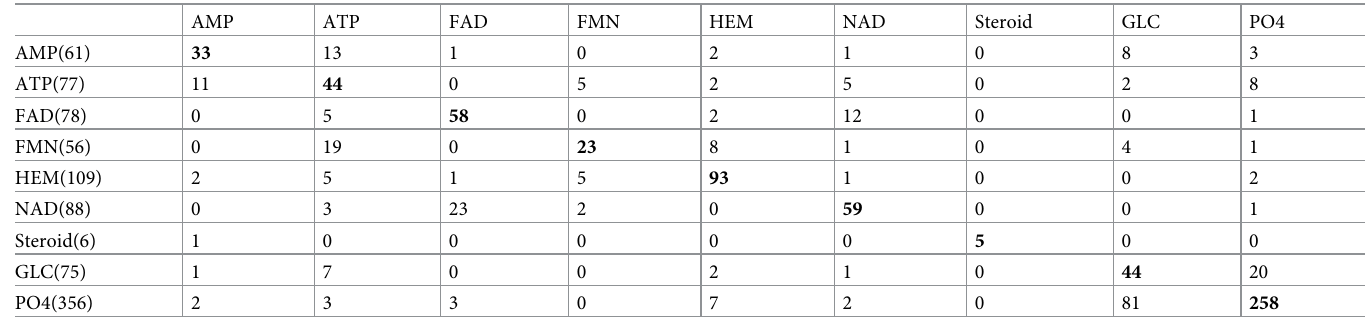
Table 6. Classification of binding sites for extended Kahraman dataset using nearest mean classification.